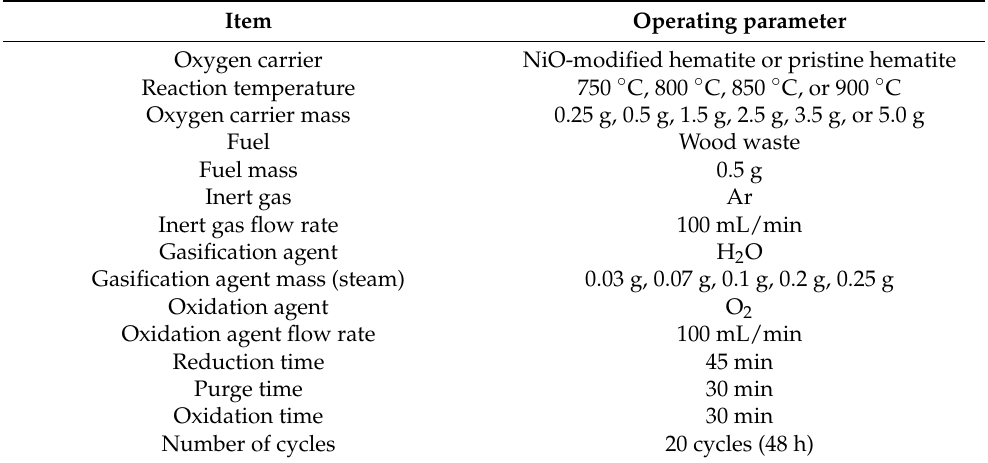
Table 3. The experimental